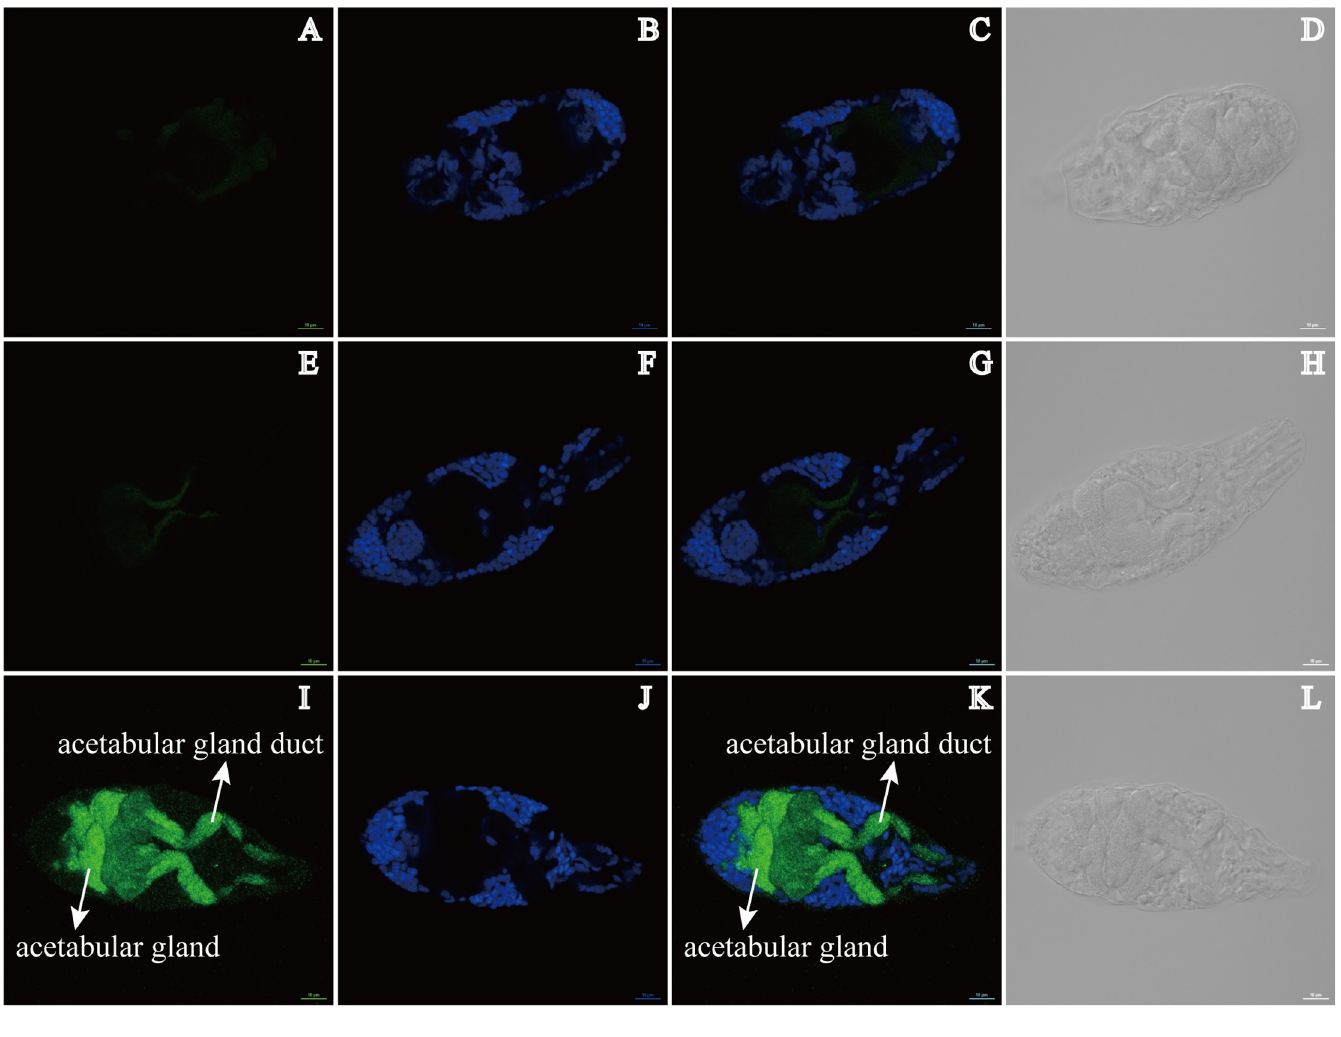
Fig 3. SjCB2 was located to the acetabular glands and their ducts (pointed out by the white arrows) in the cercariae. Rabbit polyclonal anti-rSjCB2 IgG and a Goat anti-rabbit Alexa Flour 488 were used to detect SjCB2 in cercariae. (A-D) No primary negative control. The head of the cercariae is facing to the left. (E-H) Pre-immune IgG negative control. The head of the cercariae is facing to the right. (I-L) Anti-rSjCB2 IgG. In panel I, SjCB2 is localized to the acetabular glands and their ducts. Panels B, F, and J are stained with DAPI. Panels C, G and K are merged DAPI and Alexa Flour 488 images. Panels D, H, and L are Differential Interference Contrast (DIC) images for each treatment. Scale bar, 10 μ